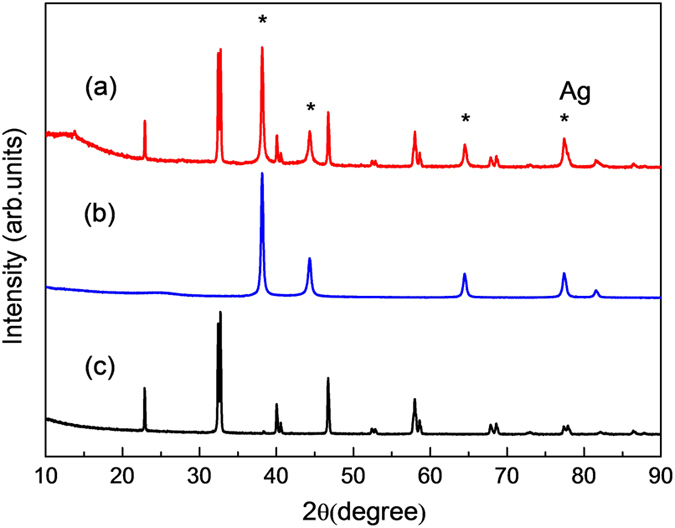
XRD patterns of (a) Ag/LaMnO3, (b) Ag/C, and (c) LaMnO3.